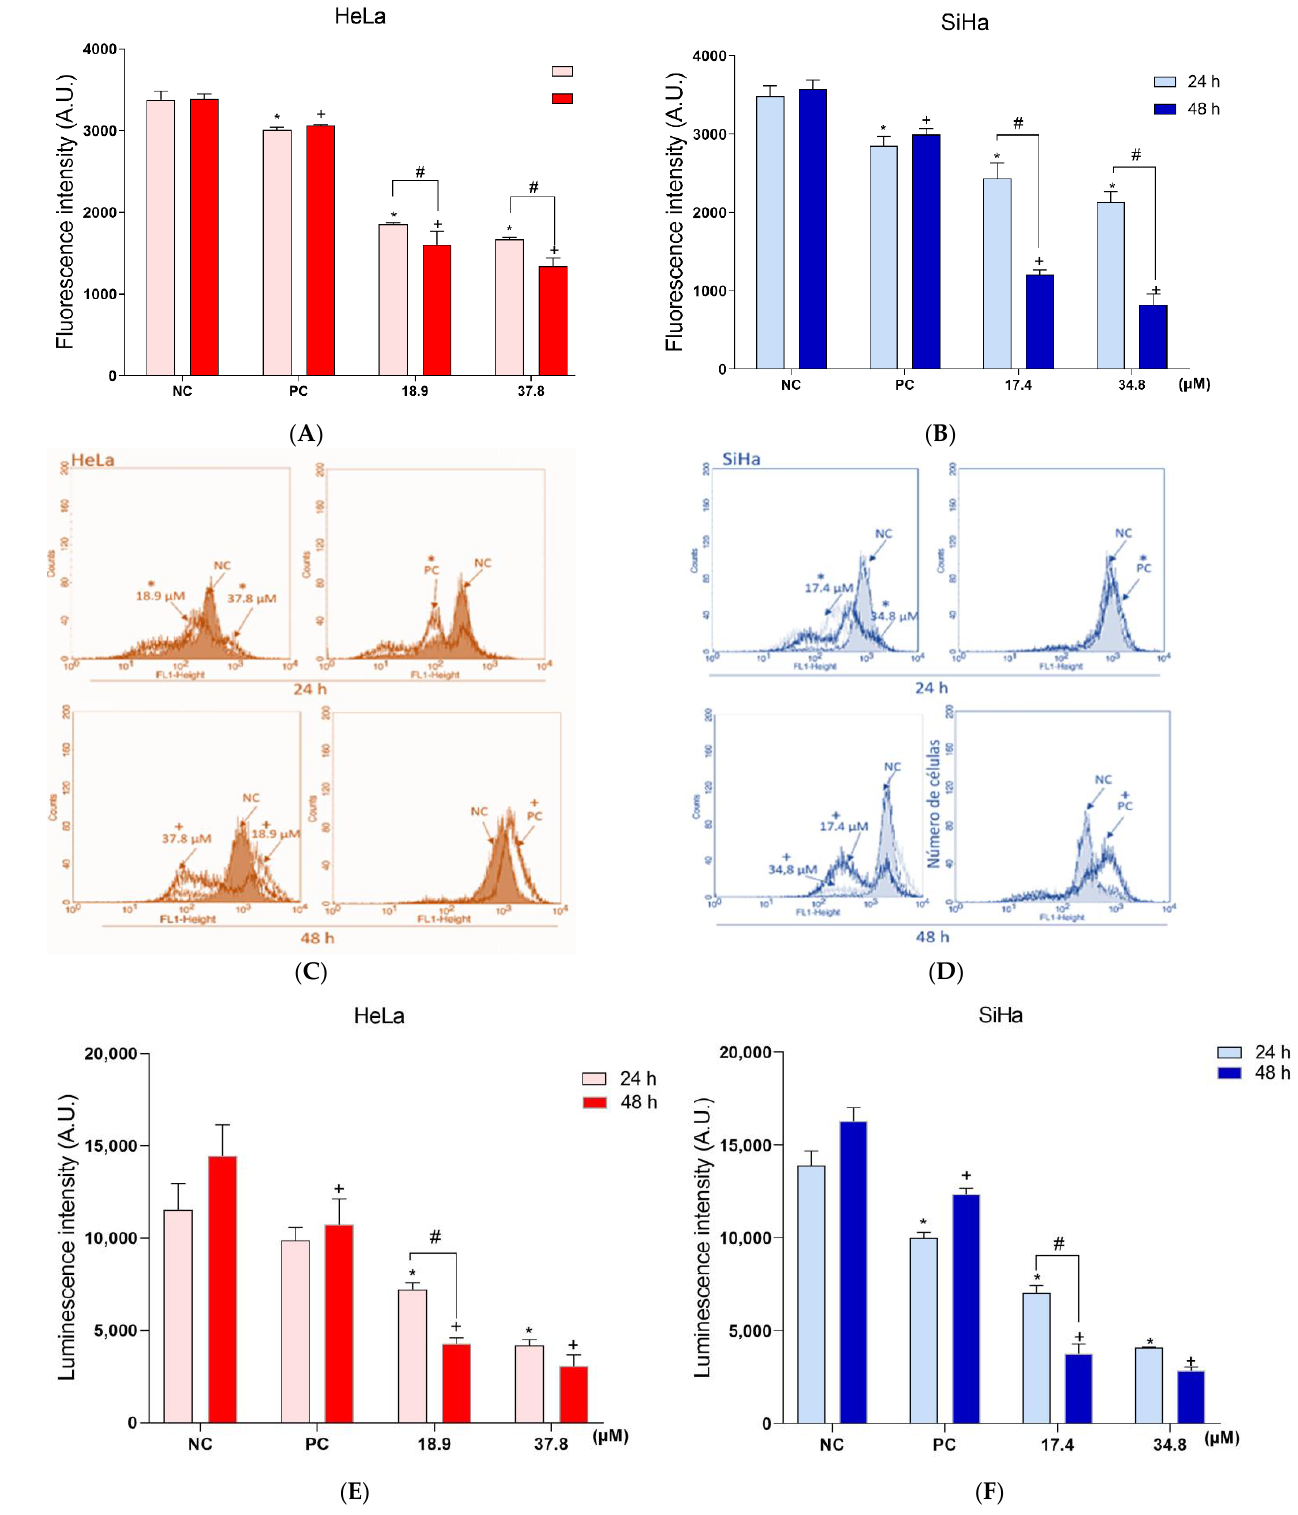
Figure 6. Effects of A3K2A3 on ΔΨm and intracellular ATP levels. Quantification of ΔΨm by TMRE marker in HeLa ( A ) and SiHa ( B ) cells. Quantification of ΔΨm by Rh 123 marker in HeLa ( C ) and SiHa ( D ) cells. Determination of intracellular ATP levels by Cell Titer-GLO reagent in HeLa ( E ) and SiHa ( F ) cells. For all assays, cells were treated with A3K2A3 (IC 50 or 2xIC 50 ) for 24 and 48 h. The PCs were CCCP (100 µM) and KCN (1000 µM). Fluorescence intensity was obtained by